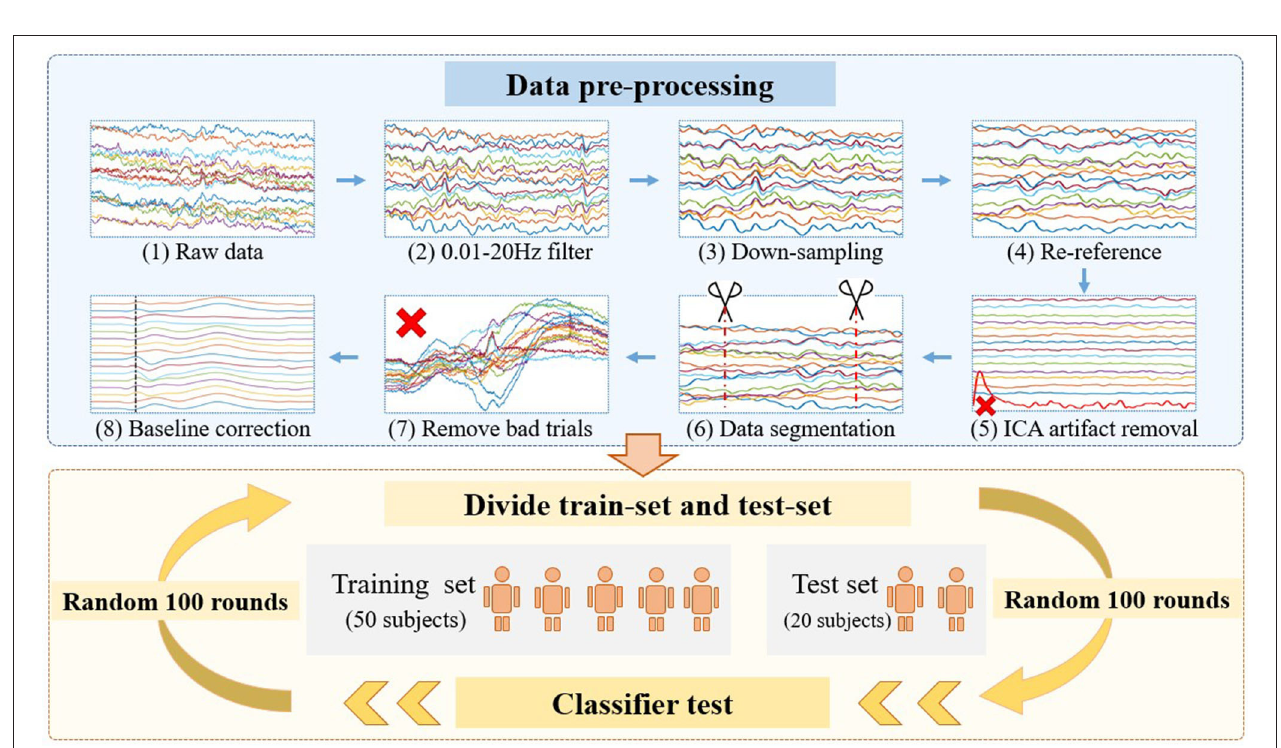
FIGURE 2 | EEG identity authentication experimental flow